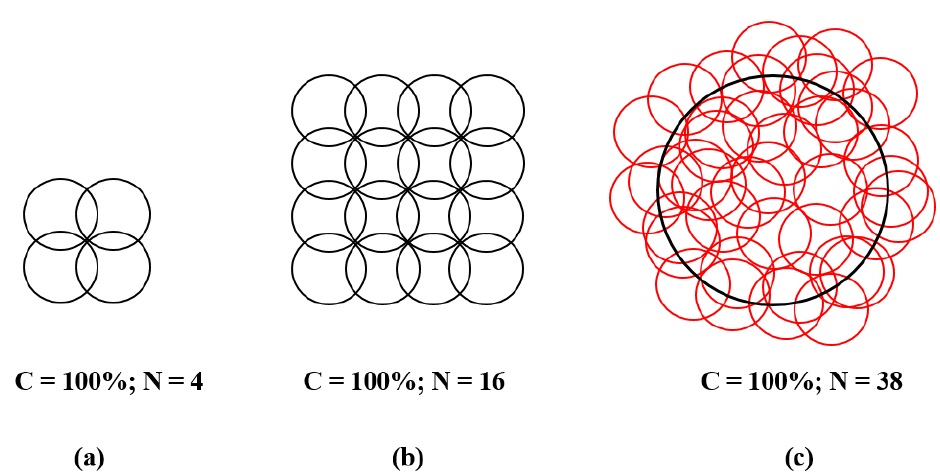
Figure 2. Schematic diagram of 100% coverage ratio dimple patterns: ( a ) N = 4 ordered dimple pattern; ( b ) N = 16 ordered dimple pattern; ( c ) N = 38 stochastic dimple pattern.